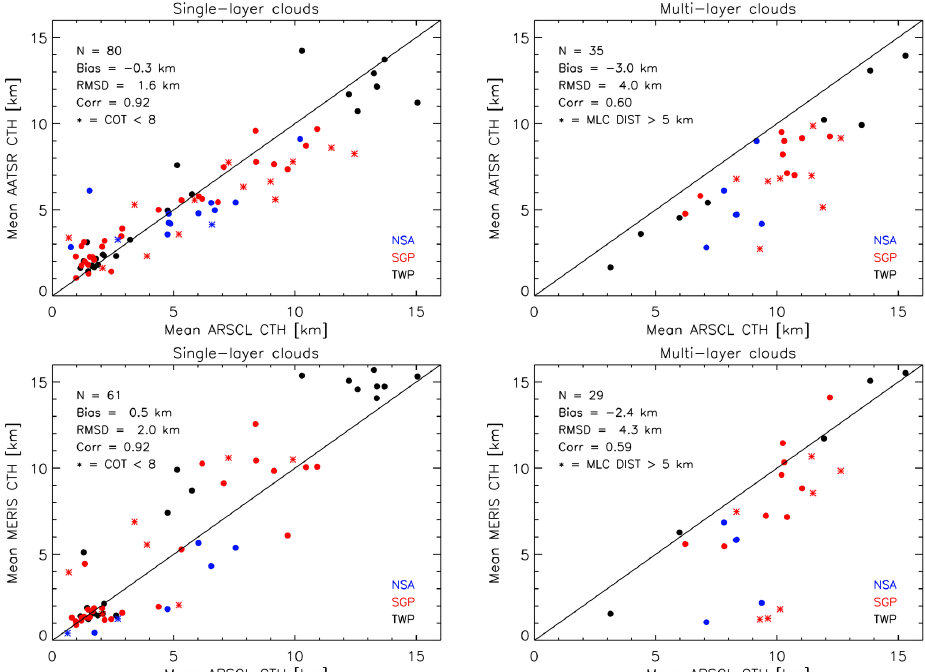
Figure 8. Results of the comparison of AATSR (top) and MERIS (bottom) mean cloud top height products with mean cloud top heights de- rived from radar observations at ARM sites for single-layer clouds (left) and multilayer clouds (right). For FAME-C the mean was computed from a 9 × 9 pixel box; for radar the mean was computed from all selected observations within a 5min time period centered at the Envisat overpass